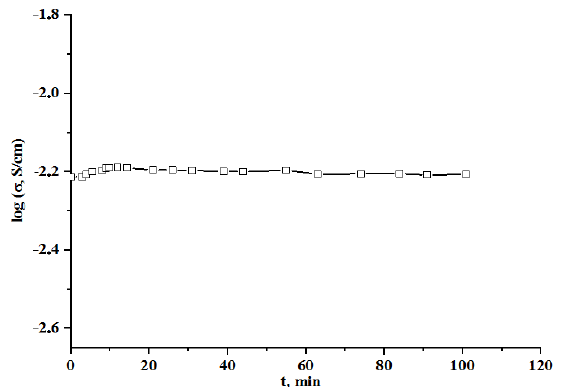
Figure 9. Dependence of conductivity of (1– x )CsH 2 PO 4 – x ZnSnO 3 ( x = 0.2) system on the time of long-term storage at 230 °C (water vapor content was 20 mol%).